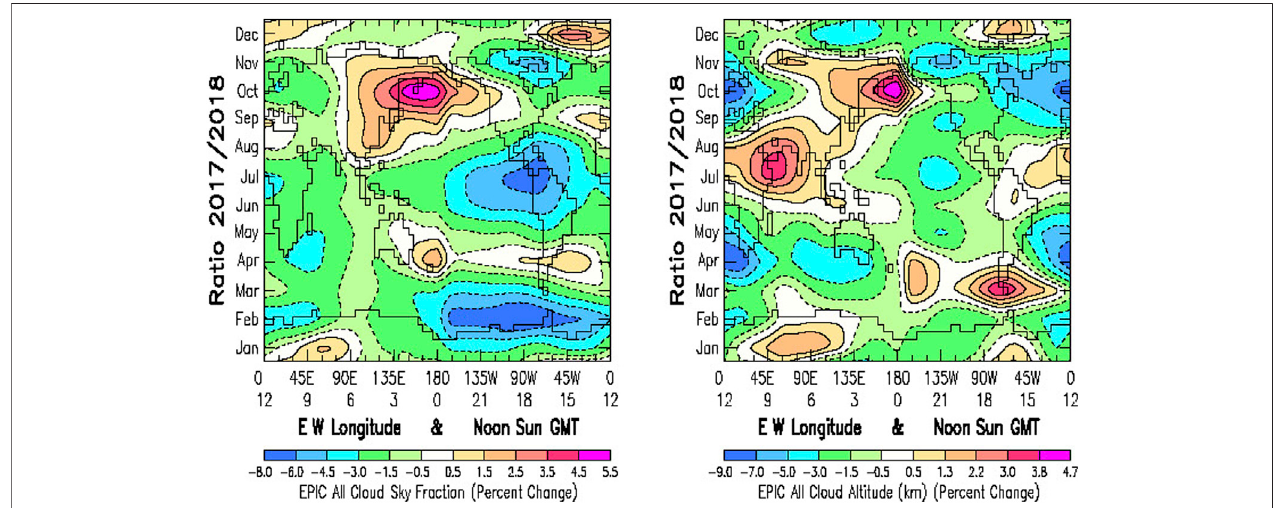
FIGURE14|Left :Hovmöllerratioplotofthepercentchangeforyear2017relativetoreferenceyear2018fortheall-cloudskyfraction,combiningtheresultsofthe separate ice cloud and water cloud sky fractions in Figure 13 , top left and top right, respectively. Right : All-cloud sky fraction, combining the results of the separate ice cloud and water cloud altitude in Figure 13 , bottom left and bottom right,